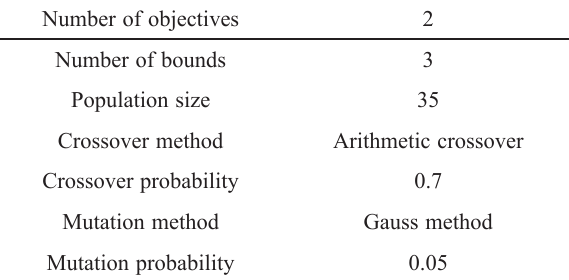
Table 5 – NSGA II input parameters Number of